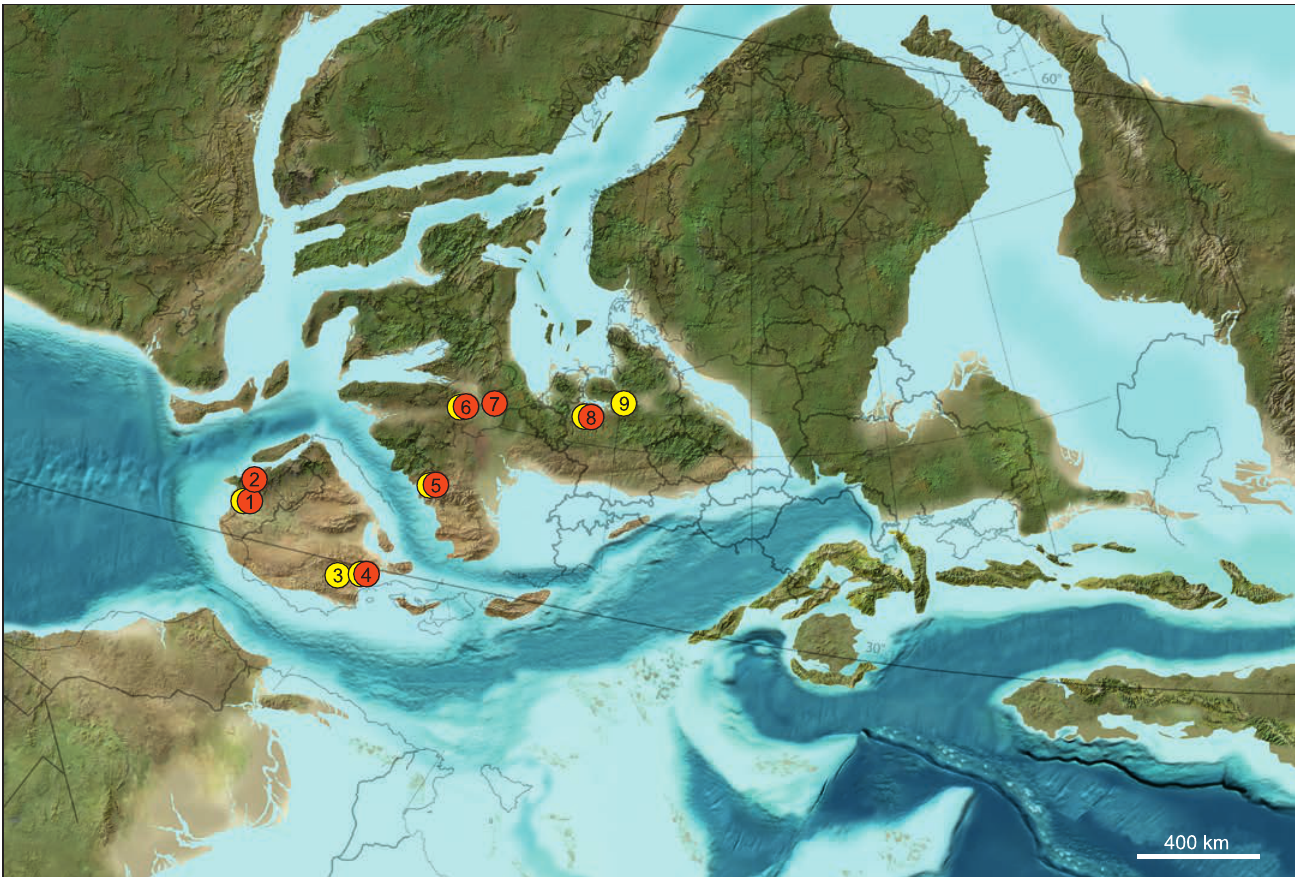
Fig. 2. Paleogeographic map of Europe in the Early Cretaceous, about 125 mya. Marked are Late Jurassic and Early Cretaceous localities that have yielded “symmetrodontans” (red) and dryolestids (yellow). 1, Guimarota Coal Mine (Portugal), Kimmerdigian; 2, Porto Pinheiro (or Dinheiro) (Portugal), Jurassic/ Cretaceous boundary (Krusat 1989); 3, Uña (Spain), Barremian; 4, Galve (Spain), Hauterivian–Barremian; 5, Cherves-de-Cognac (France), Berriasian; 6, Purbeck Limestone Group (southern England), Berriasian–Valanginian; 7, Wealden Supergroup (southern England), Berriasian–Valanginian; 8, Balve (Germany), Barremian–Aptian; 9, Langenberg Quarry (Germany), Kimmeridgian. Map by Ron Blakey, Colorado Plateau Geosystems, Phoenix,